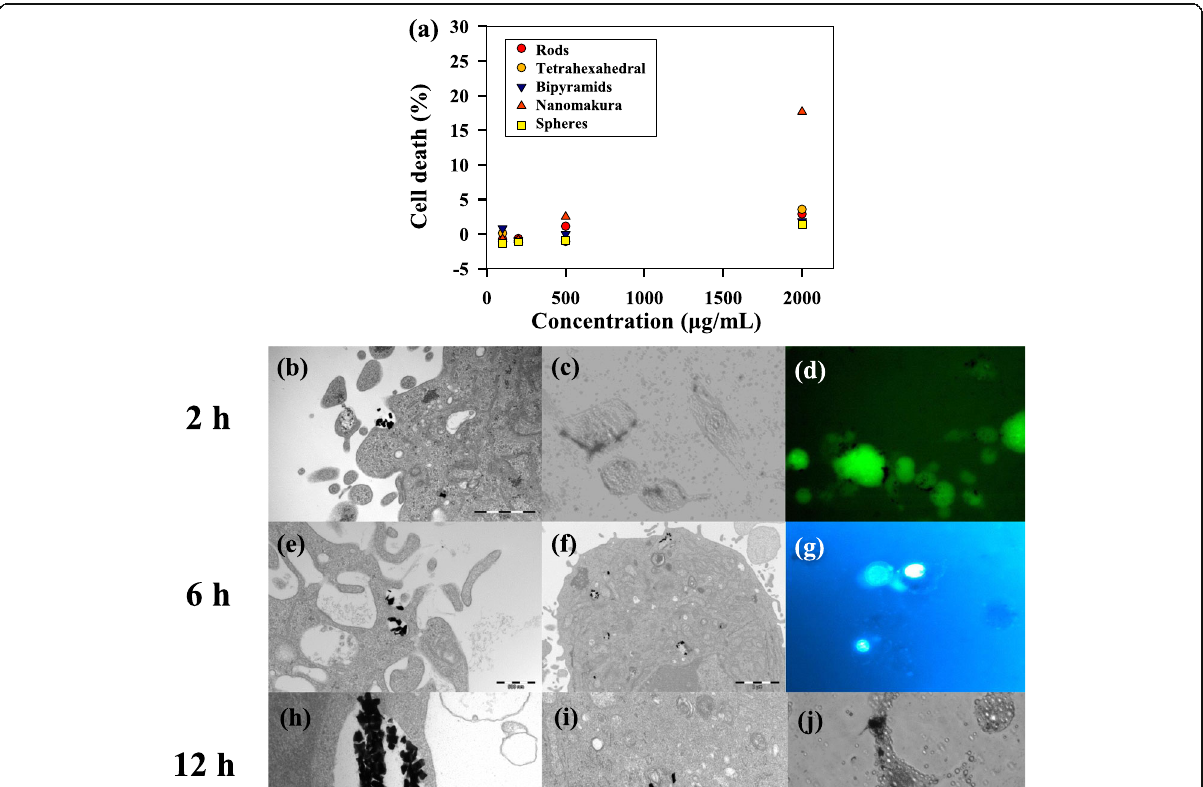
Fig. 5 Effect of Au NSs on glioblastoma-astrocytoma cells. a Percentage cell death of glioblastoma-astrocytoma cells as a function of concentration of AuNSs. Incubation time was 24 h. Images b – m are acquired after incubation of makura -shaped AuNSs in glioblastoma-astrocytoma cells taken at several time points up to 24 h. b TEM shows an invagination of the cellular membrane (m membrane, scale bar =1 μ m), and c halogen and d fluorescence images show association of makura-shaped AuNSs at the cellular membrane. e Uptake of makura-shaped AuNSs were observed after 6 h (scale bar=500 nm), f with uptake in intracellular vesicles (v vesicle, scale bar=2 μ m). g Staining of the nucleus ( n ) suggests that makura-shaped Au NSs were excluded from the nucleus. h TEM images taken after 12 h suggest uptake via macropinocytosis (scale bar =500 nm), with i intravesicular location of makura-shaped AuNSs (vm vesicular membrane, scale bar=500 nm). j Intracellular compartmentalization was also visible from the microscopy. Uptake of makura-shaped AuNSs continued at 24 h as seen in TEM images k (scale bar=2 μ m) and l (scale bar=5 μ m). m Detachment of glioblastoma-astrocytoma cells from the surface was observed, which most likely is an indication of cell